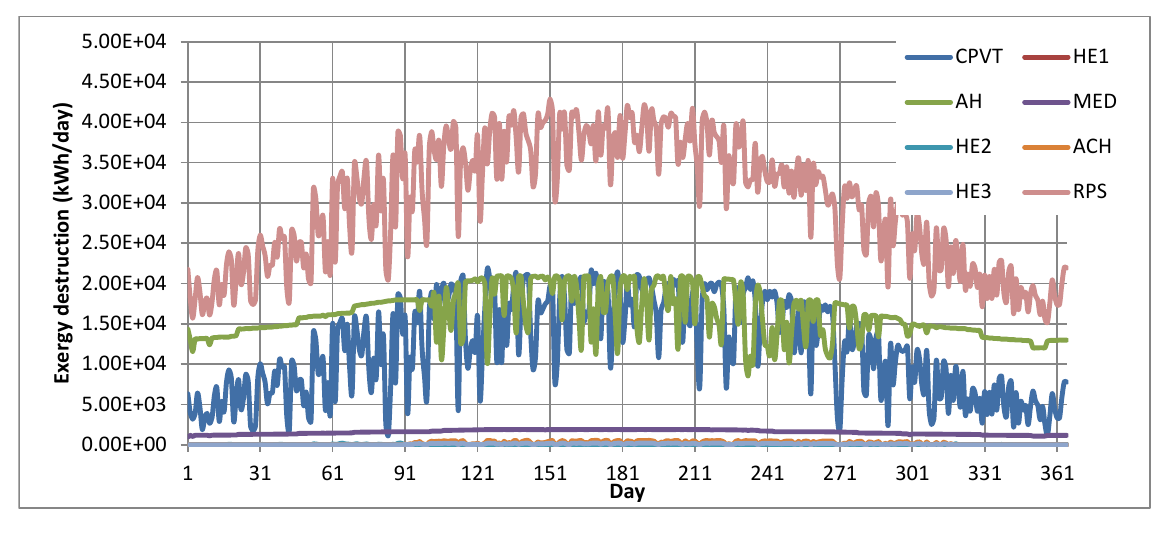
Figure 5. Daily exergy destruction.